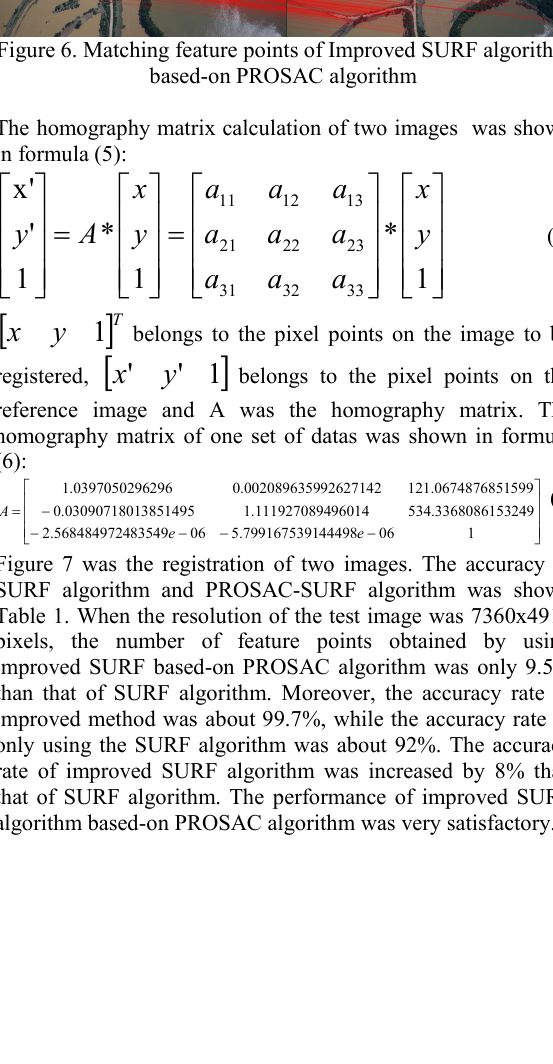
Figure 8. Comparison of operation time between SURF and